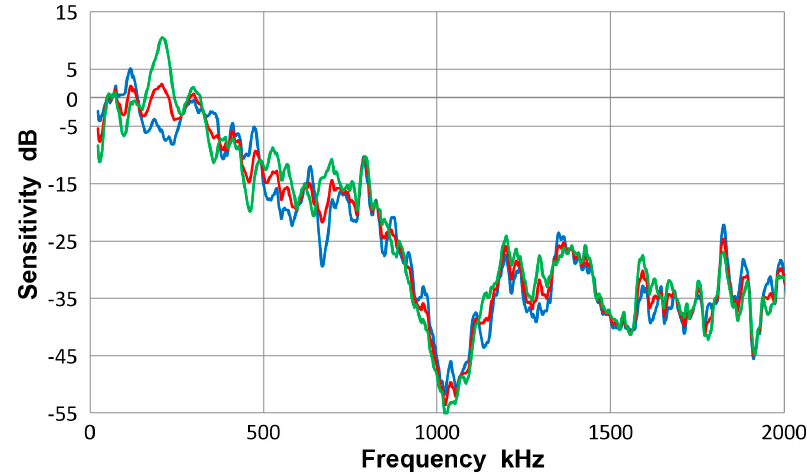
Figure 17. Receiving sensitivity of PAC F30a sensor. Red -averaged guided wave sensitivity, blue -Lamb waves for 12.7 and 6.4 mm plates, green -bar waves for 12.7 and 6.4 mm bars.